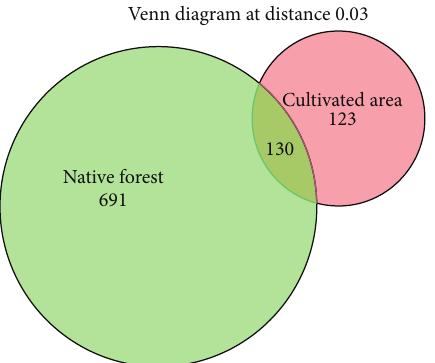
Figure 2: Venn diagram depicting the number of shared and unique operational taxonomic units (OTUs) in native forest and oil palm- cultivated area.